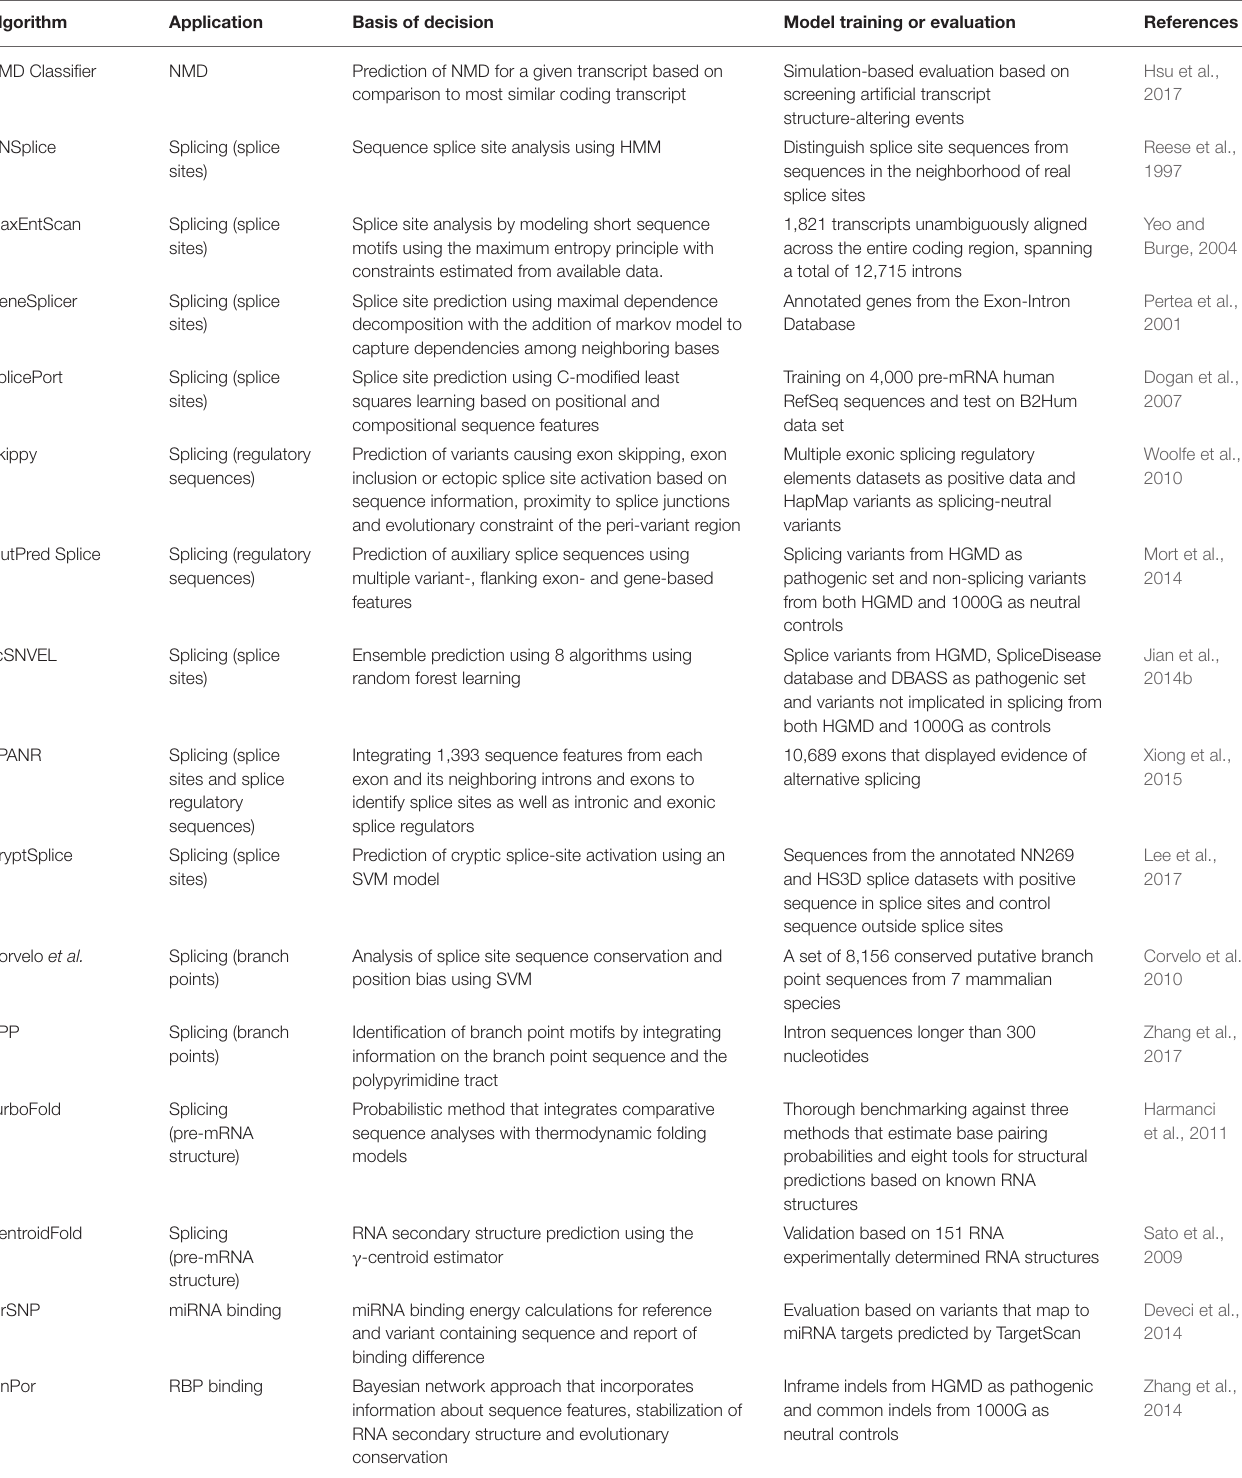
TABLE 3 | Tools for the prediction of variant effects on splicing, transcript levels or